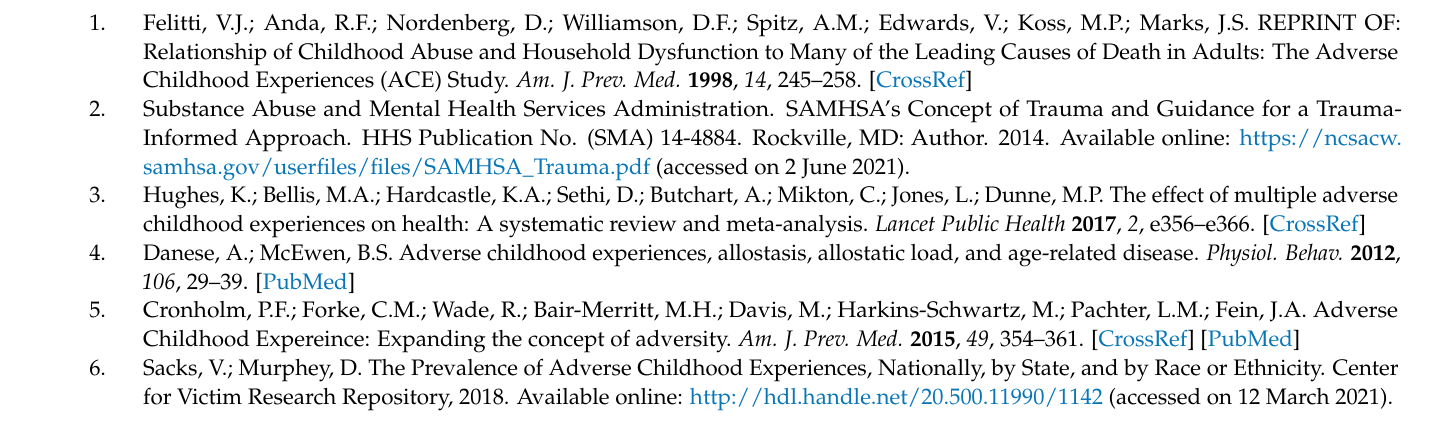
Figure A2. Worksheet to help guide ARCCH conversation with an organization/system.